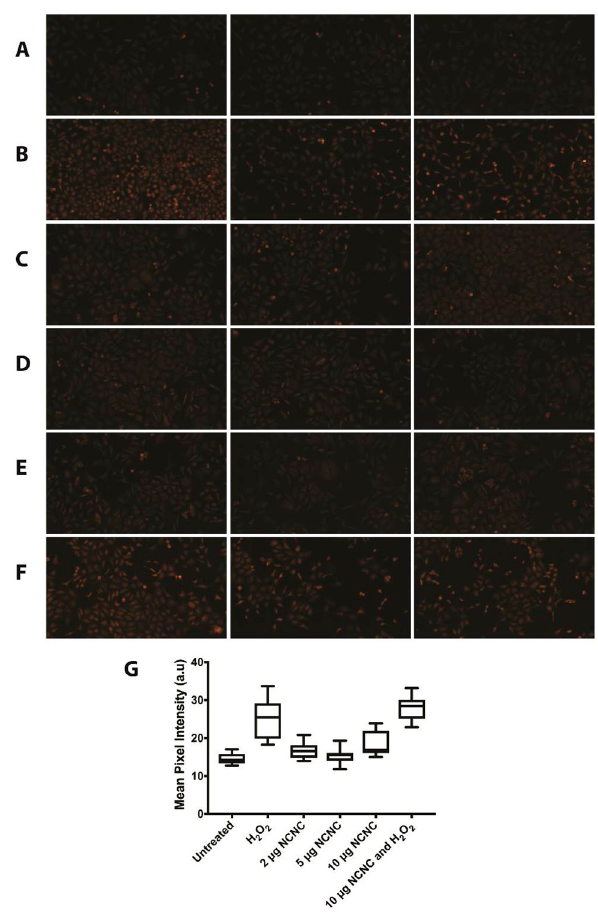
Figure 3. Dihydroethidium (DHE) staining for reactive oxygen species (ROS) in NCNC treated HeLa Cells. Pictured are representative images that are closest to the average pixel intensity for each treatment. ( A ) Untreated HeLa cells. ( B ) HeLa cells treated with 500 µ M H 2 O 2 for 2 h. ( C ) Hela cells treated with 2 µ g / mL NCNC for 24 h. ( D ) HeLa cells treated with 5 µ g / mL NCNC for 24 h. ( E ) HeLa cells treated with 10 µ g / mL NCNC for 24 h. ( F ) HeLa cells treated with 10 µ g / mL NCNC for 24 h and 500 µ M H 2 O 2 for 2 h. ( G ) Quantification of mean pixel intensity of images from treatments. Upper and lower bar represents maximum and minimum respectively. Central bar in box plot represents the mean. Each treatment has an n ≥ 7 images. For cells treated with 5 µ g / mL NCNC, an outlier was omitted using the ROUT method for identifying outliers, reducing the sample set to seven images. The results remained the same if the outlier were to remain part of the data set.